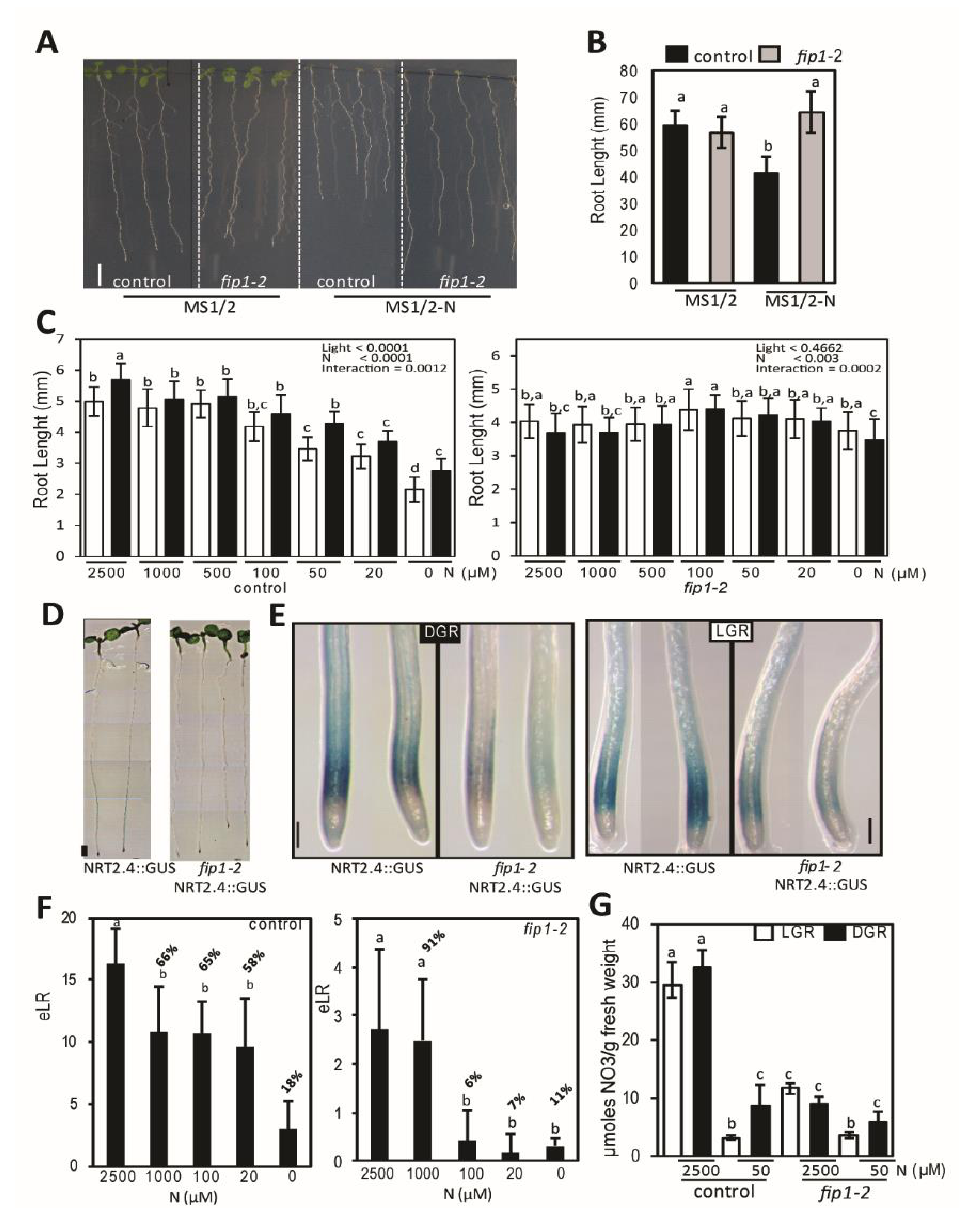
Figure 1. Root illumination and polyadenylation affect root growth and LR formation under nitrogen starvation. ( A ) Representative pictures of control and fip1-2 mutant grown for 10 days in MS1/2 with or without nitrogen. Scale bar: 1cm. ( B ) Root growth quantification of seedlings grown as in A. ( C ) Root growth of 10-days-old control or fip1-2 seedlings grown with different concentrations of nitrogen. White and black bars correspond to light- or dark-grown root seedlings respectively. ( D ) Representative picture of GUS staining NRT2.4::GUS seedlings grown in MS1/2 medium for 5 days and then transferred to MS1/2 containing 50 µM of N for 2 extra days. Scale bar: 1 cm. ( E ) Higher magnification of the root tip from seedlings shown as in A. Scale bar: 500 µm. ( F ) Number of emerged lateral roots (eLR) of control or fip1-2 seedlings grown in MS medium containing different concentrations of nitrogen during 10 days. Numbers above the bar correspond to the percentage of eLR with respect to the maximum nitrogen medium (2500 µM). ( G ) Amount of NO 3− in control or fip1-2 grown during 10 days in medium containing high N (2500 µM) or low N (50 µM). (B,F) Significance was analyzed by ANOVA and Tukey HSD post-hoc test. p < 0.05. (C,G) Significance was analyzed by two-way ANOVA and Bonferroni post-hoc test. Error bars correspond to S.E.